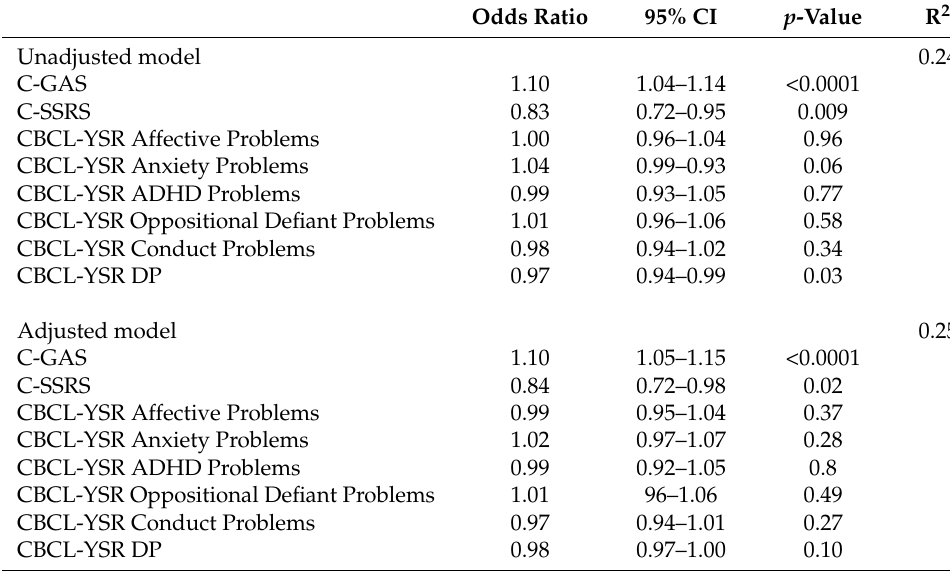
Table 4. Second logistic regression model predicting Revolving Door with the reference category for each variable